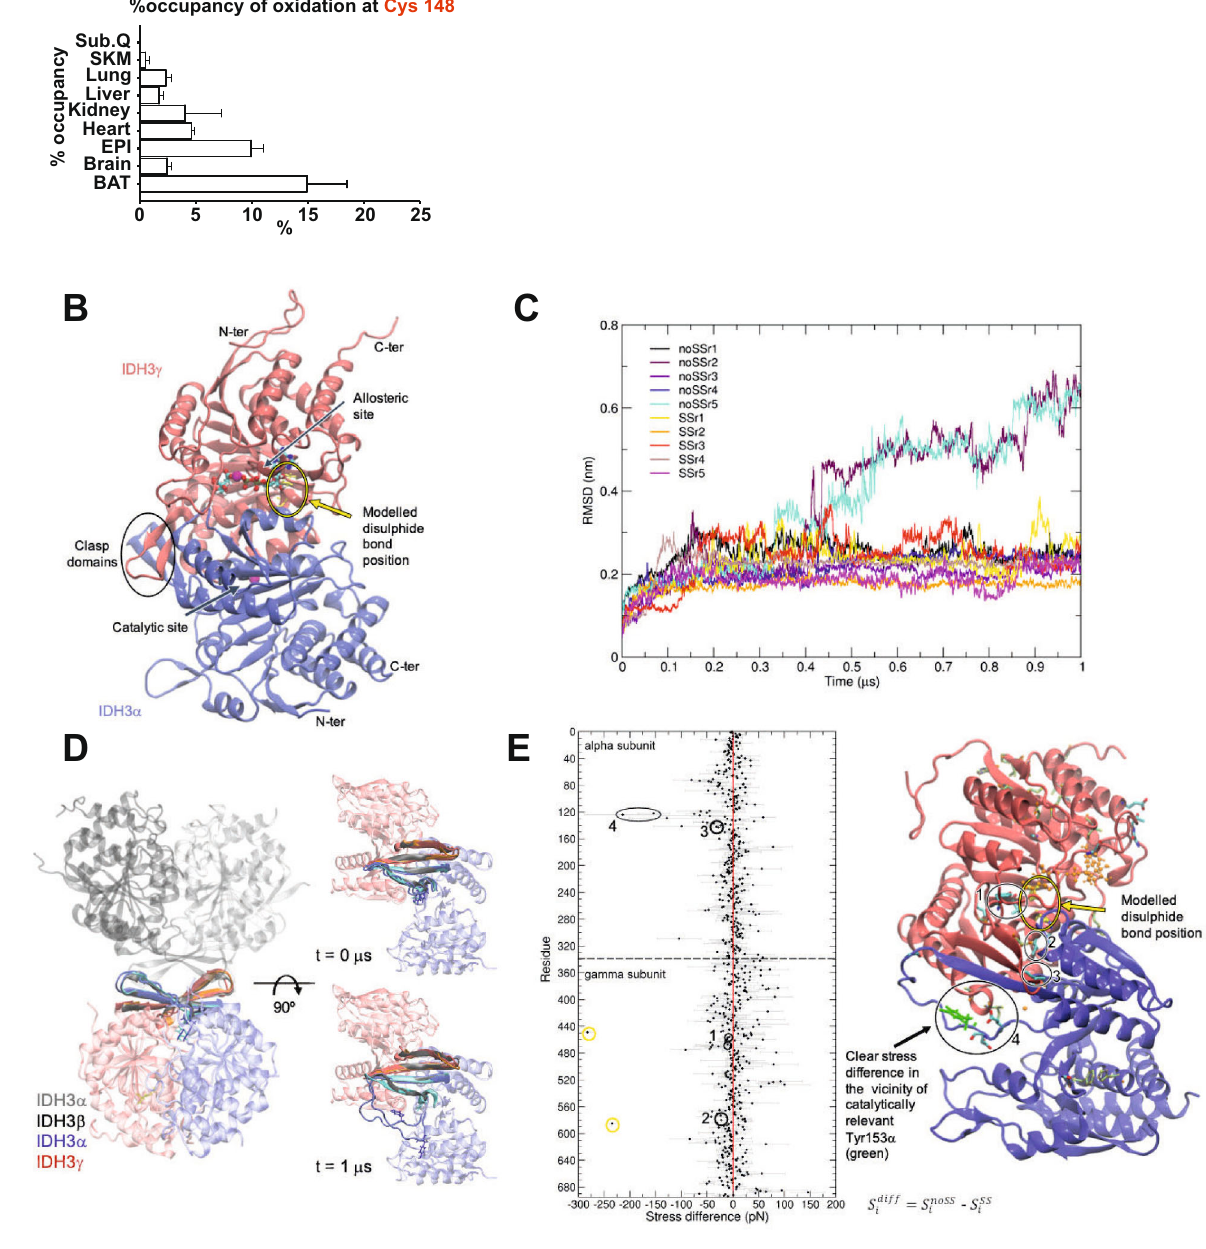
Fig. 6 | Disul fi de-bridge formation between IDH3 γ Cys148 and Cys284 changes the tetramerization interface of IDH3. A Quanti fi cation of IDH3 γ Cys148 oxida- tion as the percentage of occupancy in different tissues from n =5 biologically independent 16-week-old male C57BL/6J mice. Data are obtained from the Oxi- mouse database. subQ subcunateous fat, SKM skeletal muscle, epi epididymal fat, BATbrownadiposetissue.mean±SEM. B StructureoftheIDH3 α / γ dimerwithmain functional sites. Citrate, Mg 2+ and ADP are shown as ball and sticks. C Root mean square deviation (RMSD) plot for the clasp region for each system/replica. D Selected clasp regions from the two simulations showing substantial con- formational changes (noSSr2, noSSr5, in blue for α subunit and red for γ subunit) and one stable reference (SSr2, in cyan for α subunit and orange for γ subunit)